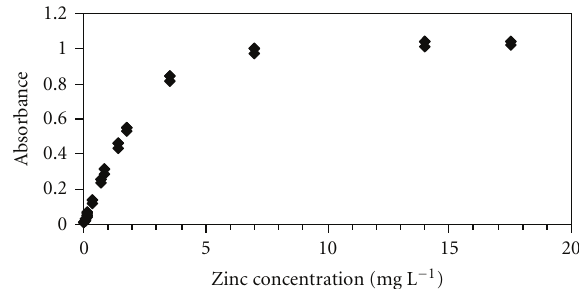
Figure 1: Analytical curve for Zn in 0.11M acetic acid measured in FAAS with the HSSR method at 213.856